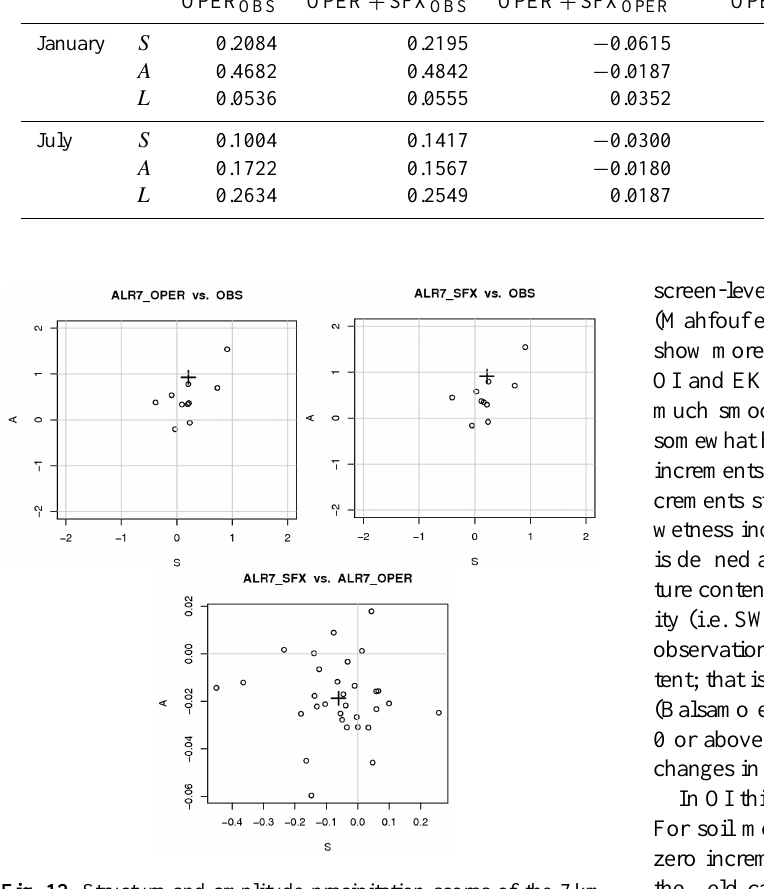
Fig. 12. Structure and amplitude precipitation scores of the 7km ALARO run for January 2010. Against radar observation (top), the OPER run (left) and the run with SURFEX (right). The run with SURFEX against the operational run (OPER) (bottom), where each point corresponds to 1 day. The cross indicates the weighted